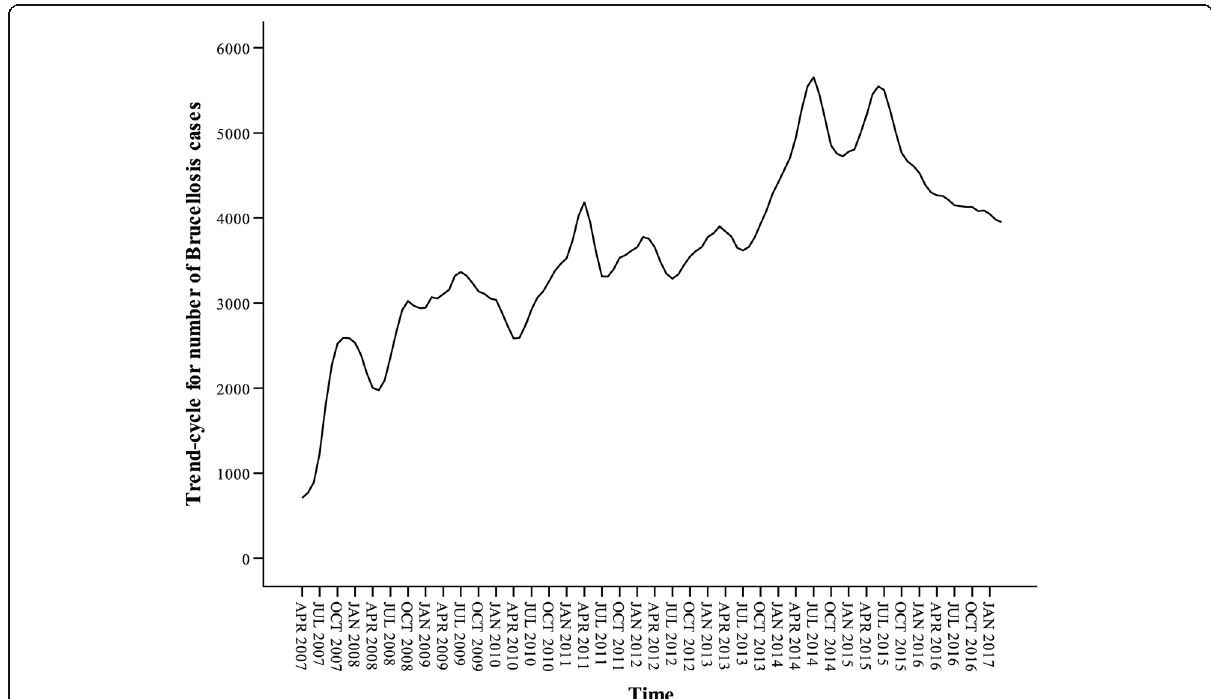
Fig. 3 Cycle and trend of the monthly reported cases of human brucellosis in Mainland China, April 2007 – March 2017 (Exponential smoothing method based on the additive model)